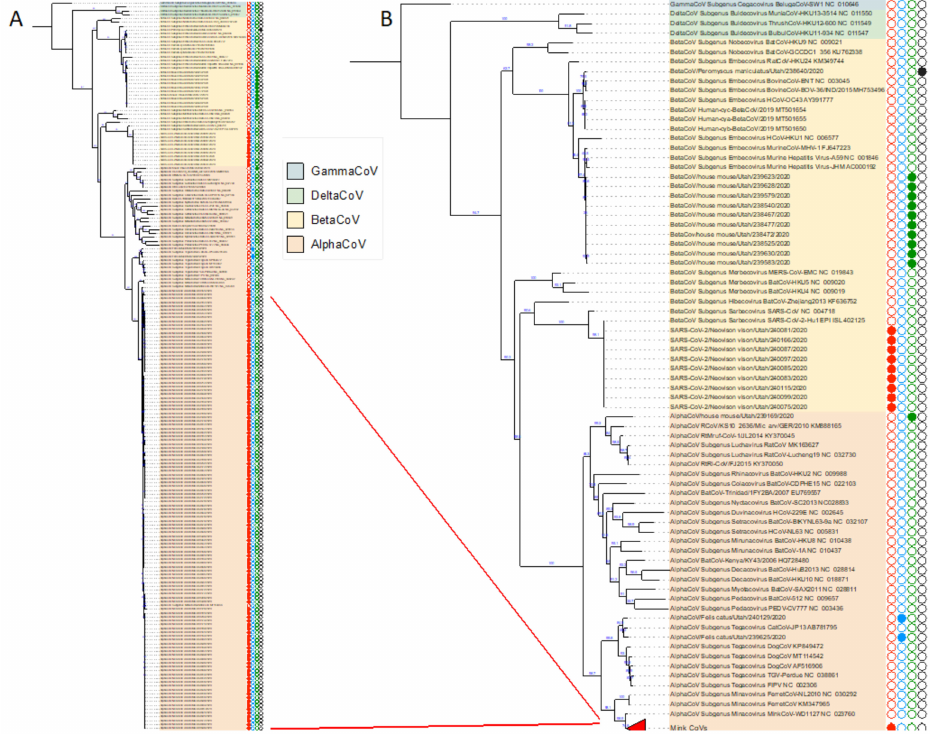
Figure 1. Phylogenetic relationships of the identified coronaviruses from mink and other animals from mink farms in Utah. The four genera of coronaviruses are highlighted in different colors. Alpha- CoV, alphacoronavirus; BetaCoV, betacoronavirus; DeltaCoV, deltacoronaviruses, and GammaCoV, gammacoronavirus. Type species for the currently recognized subgenera are with the ICTV subgenus, strain name and the GenBank locus name. Panel A. Full phylogenetic tree (A full-size image is included in Supplementary Figure S1). Red lines designate the group of nearly identical Utah mink coronavirus strains collapsed into the colored triangle in Panel B. Circles denote animal species; red, American mink; blue, cat; green, house mouse; black, deer mouse. Filled circles denote strains characterized in this